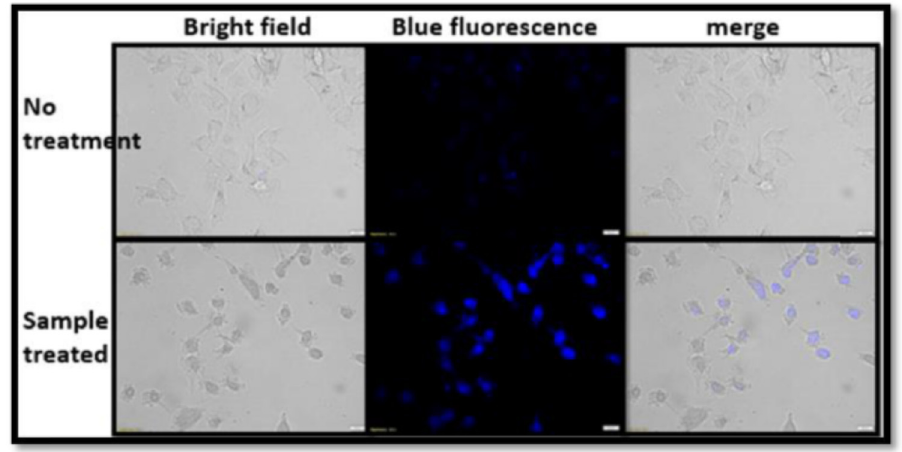
Figure 4: Confocal microscopy images of cancer prostate epithelial RWPE - 1 cells utilizing MDGOs as a sensing material [ 52 ] . Copyright © 2022;